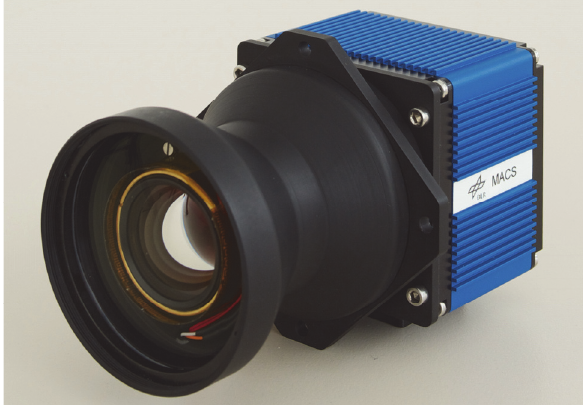
Figure 2. One of three RGB sensor modules